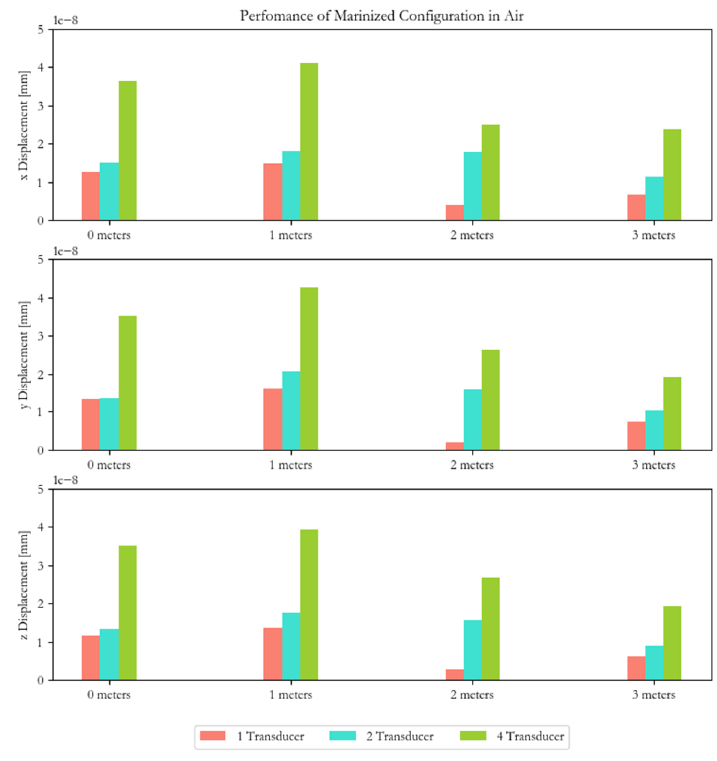
Figure 13. Performance of marinized configuration in air.